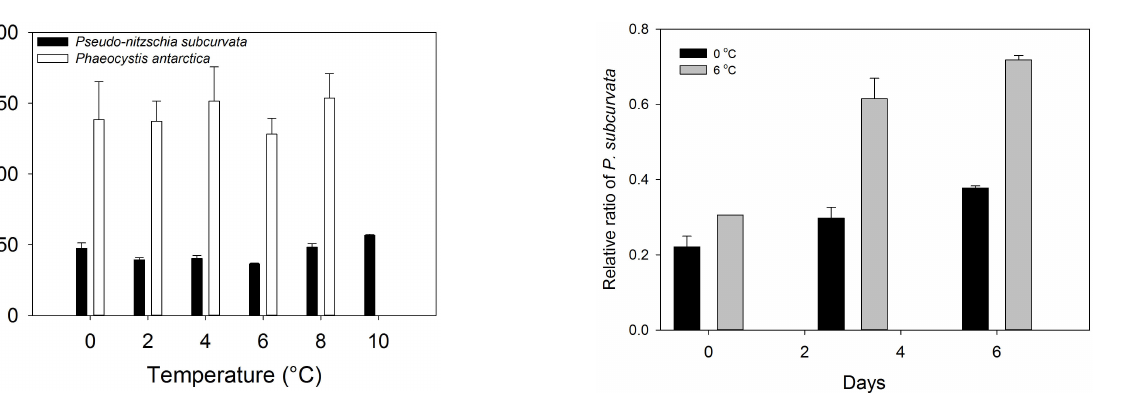
Figure 4. The relative abundance of Pseudo-nitzschia subcurvata in a 6-day competition experiment with Phaeocystis antarctica at 0 and 6 ◦ C. The competition experiments were started with equal Chl a concentrations for both species, and the relative abundance was calculated based on cell counts. Values represent the means and error bars represents the standard deviations of triplicate